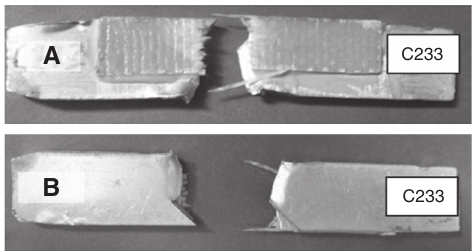
Figure 10 Fracture of different repaired specimens: (A) C233 in front view, (B) C233 in back view.